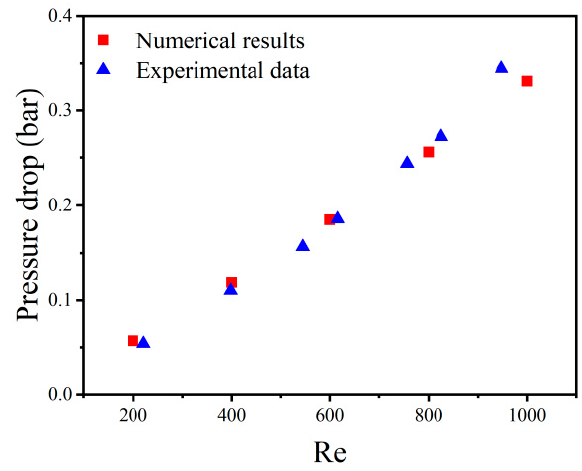
Figure 5. Comparison between numerical and experimental data.